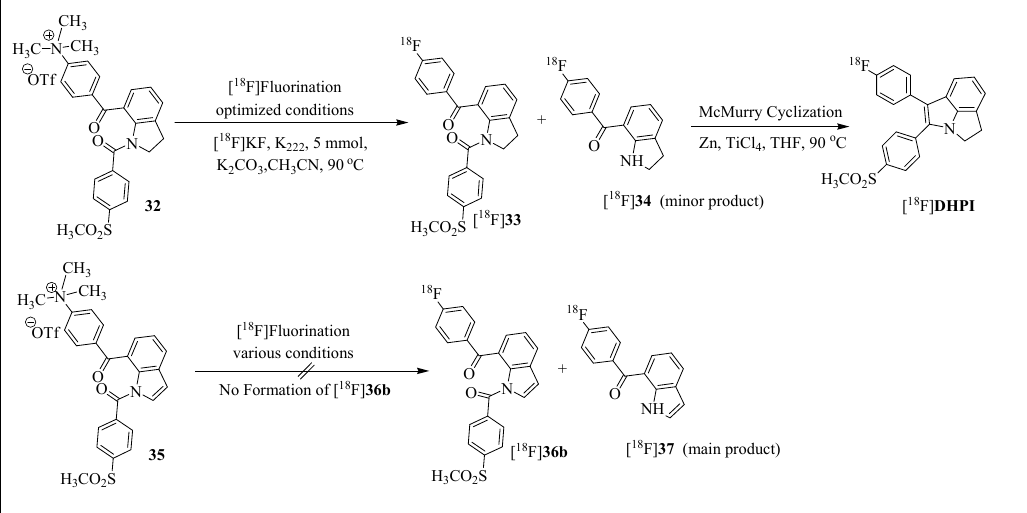
Figure 11. Radiosynthesis route leading to [ 18 F]DHPI . [ 18 F]Fluorination of indoline precursor 32 under optimized conditions forms intermediate [ 18 F] 33 , which is subsequently cyclized to [ 18 F]DHPI by McMurry reaction. The [ 18 F]fluorination of indole precursor 35 furnished only side product [ 18 F] 37 instead of [ 18 F] 36, so the McMurry reaction was not feasible.